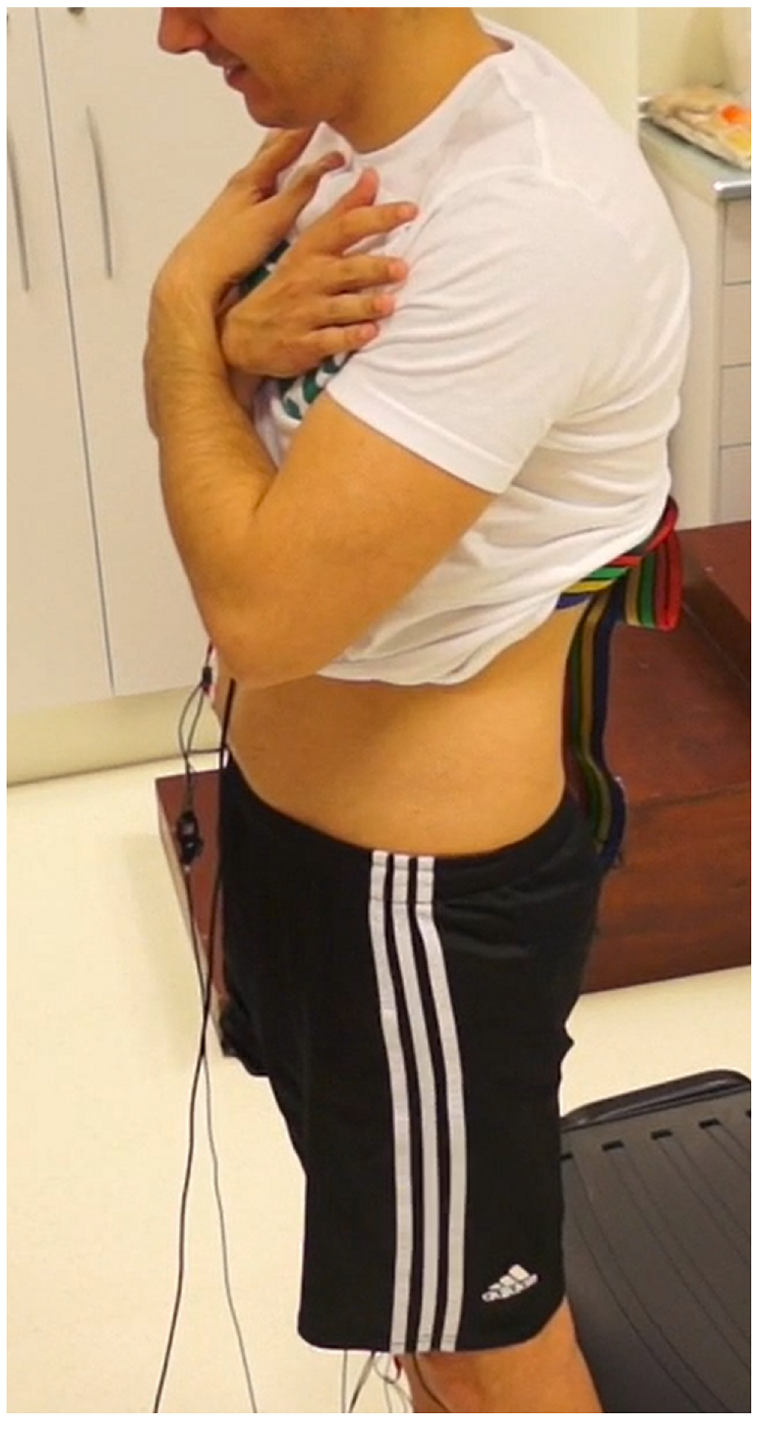
Fig 1. STS starting position.